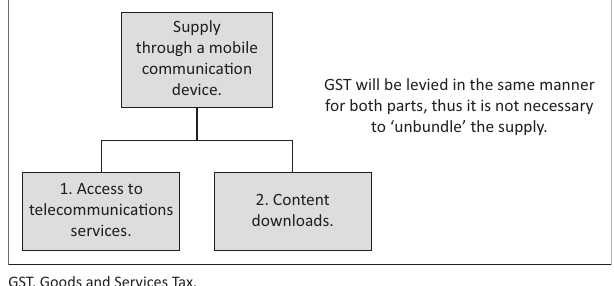
FIGURE 1: Bundling of telecommunication services in Australia (OECD